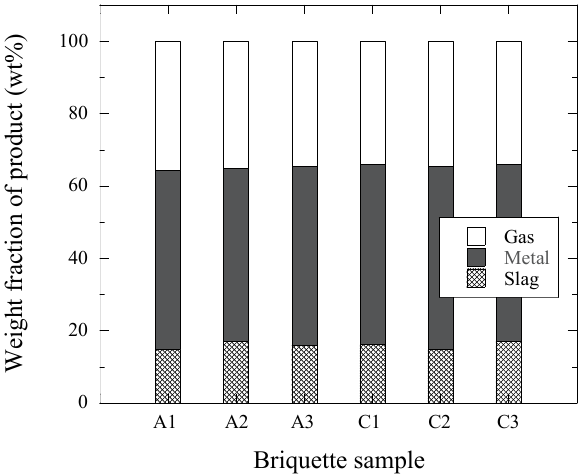
Figure 5. Amounts of gas, metal and slag formed from different briquettes during the TGR experiments at 1500 °C.